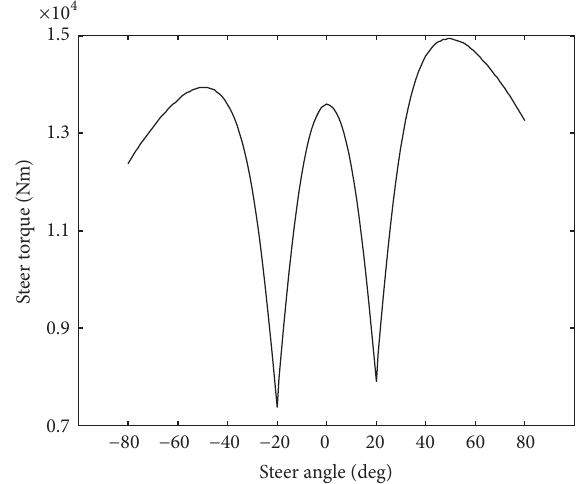
Figure 6: Steer torque versus steer angle at constant pressure 16.55 MPa.